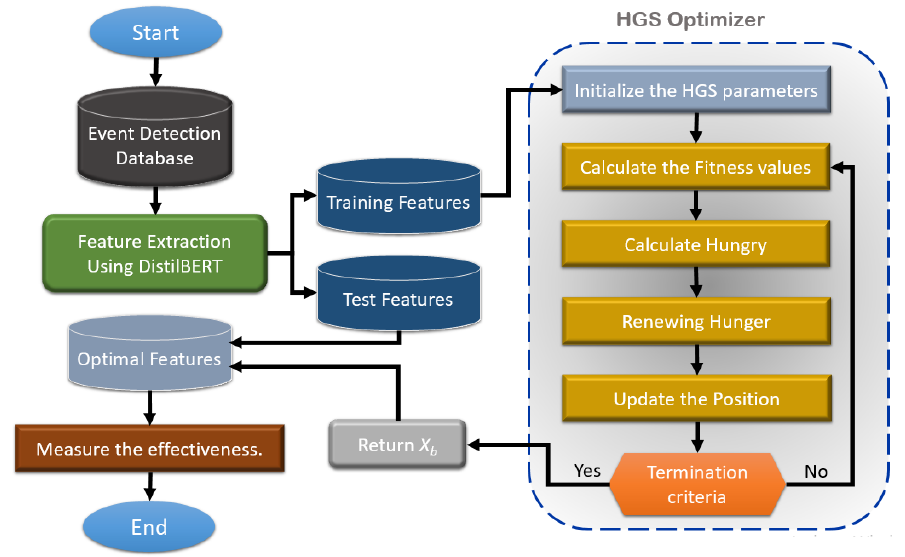
Figure 3. Flowchart of the proposed methodology.